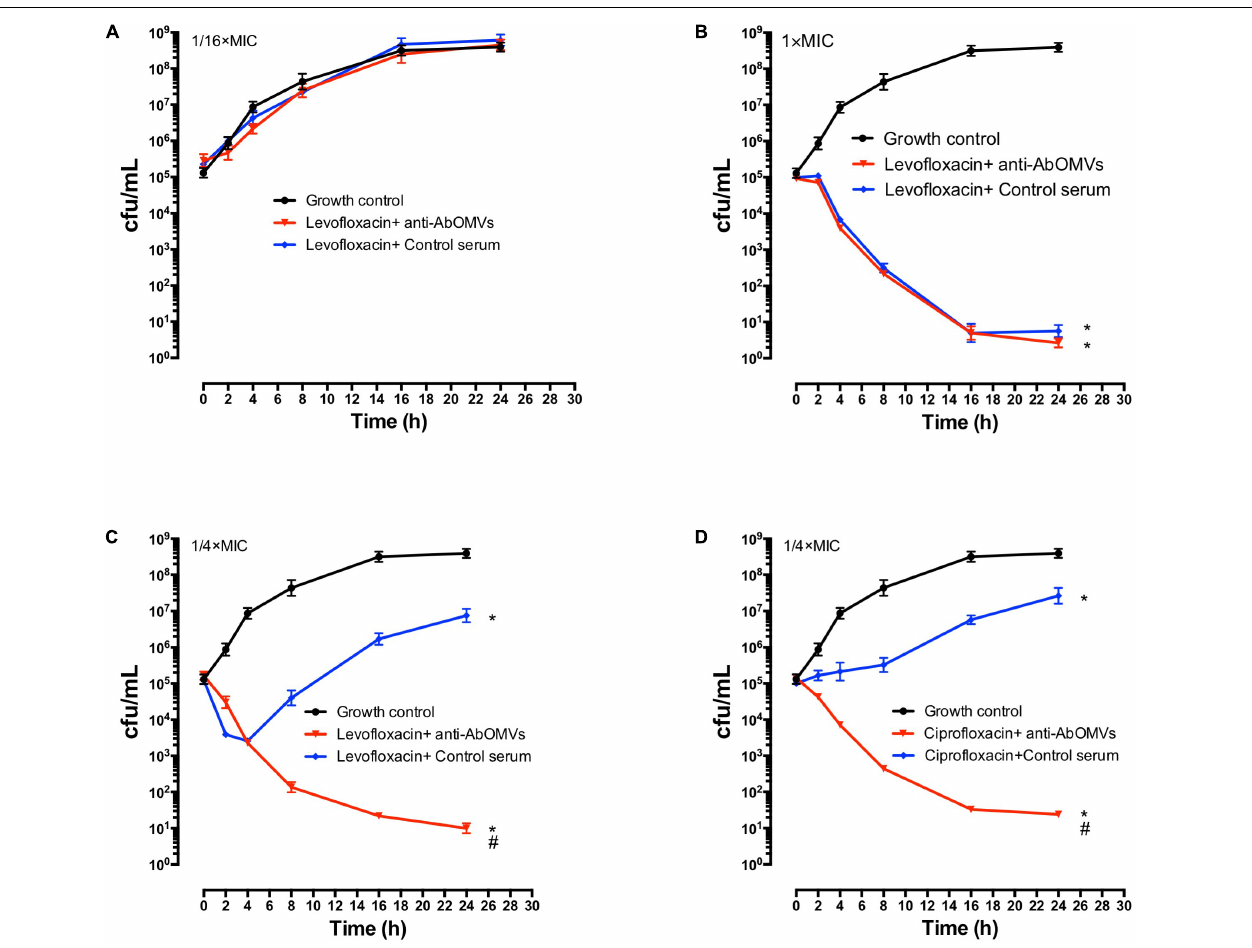
FIGURE 3 | Anti-AbOMV serum improved the sensitivity of PDR A. baumannii to antibiotics in vitro. Levofloxacin at concentrations of (A) 1/16 of the MIC, (B) 1x the MIC, and (C) 1/4 of the MIC was combined with anti-AbOMV or control serum for 24 h and then viable bacteria (CFU/mL) were counted. (D) Ciprofloxacin at a concentration of 1/4 of the MIC was combined with anti-AbOMV or control serum for 24 h and bacteria were counted (CFU/mL). ∗ Indicates anti-AbOMV antiserum or control serum compared with the PBS control; # indicates anti-AbOMVs compared with the control serum group. The experiment was repeated three times. ∗ / # P <